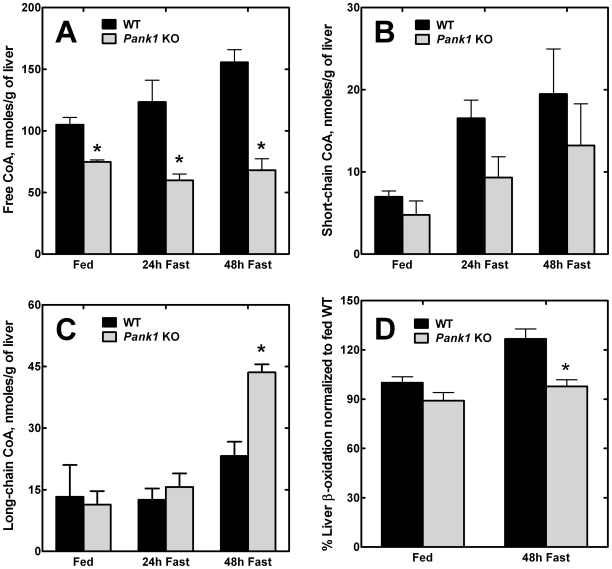
CoA levels and fatty acid oxidation in the PanK1-deficient liver.(A) Levels of free CoA were measured in livers from 4 wild-type (WT) and 4 Pank1 knockout (KO) mice and reported as a function of tissue wet weight. The mice were fed ad libitum, or fasted for either 24 or 48 h. The data are the averages of duplicate measurements on each mouse of each genotype ± standard error. (B) Levels of short-chain acyl-CoA were measured in livers from wild-type (WT) and Pank1 knockout (KO) mice and reported as a function of tissue wet weight. The acyl chain lengths include C2 through C12, inclusive. The mice were fed ad libitum, or fasted for either 24 or 48 h. The data are the averages from duplicate measurements from 4 control and 4 knockout mice ± standard error. (C) Levels of long-chain acyl-CoA were measured in livers from wild-type (WT) and Pank1 knockout (KO) mice and reported as a function of tissue wet weight. The acid-insoluble long-chain acyl-CoAs include C14∶0 and longer [75]. The data are the averages from duplicate measurements from 4 control and 4 knockout mice ± standard error. (D) Rates of fatty acid oxidation were measured in liver extracts derived from 4 fed wild-type (WT) or 5 fed knockout (KO) mice. Rates of fatty acid oxidation were measured in liver extracts derived from 4 wild-type (WT) or 5 knockout (KO) mice fasted for 48 h. 100% corresponds to 7.7 pmoles of 3H-palmitic acid oxidized/min/mg protein. The data are the averages of duplicate measurements from control and knockout mice ± standard error. Statistically significant differences between wild-type and knockout are indicated by * (p<0.05).